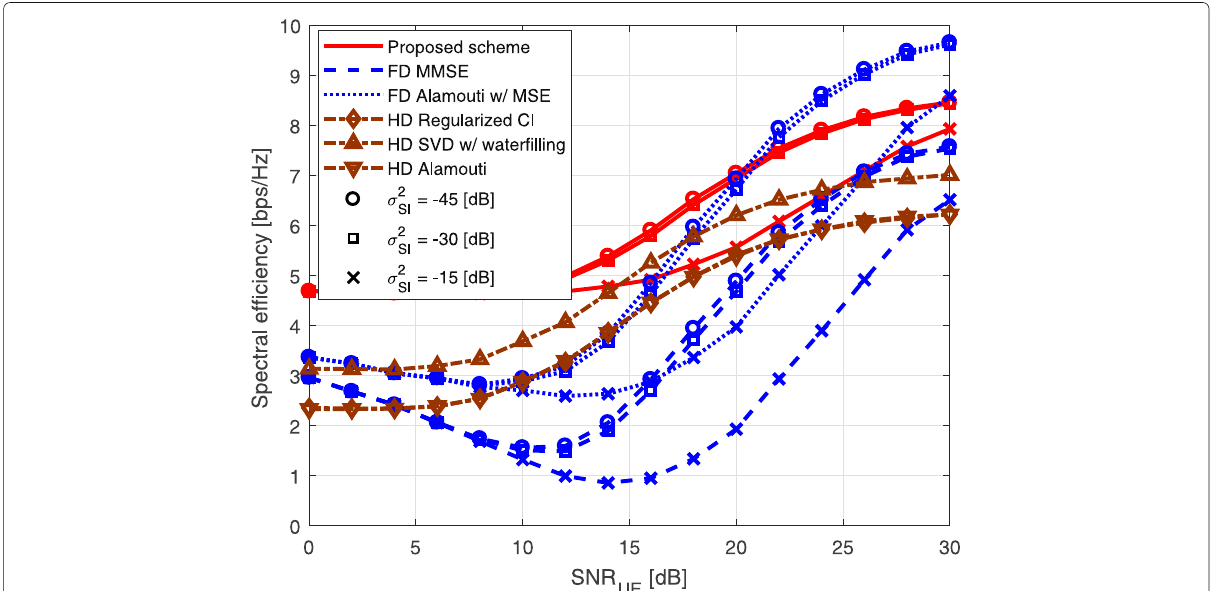
Fig. 5 The sum spectral efficiencies of the proposed scheme and the existing schemes according to UE transmission power